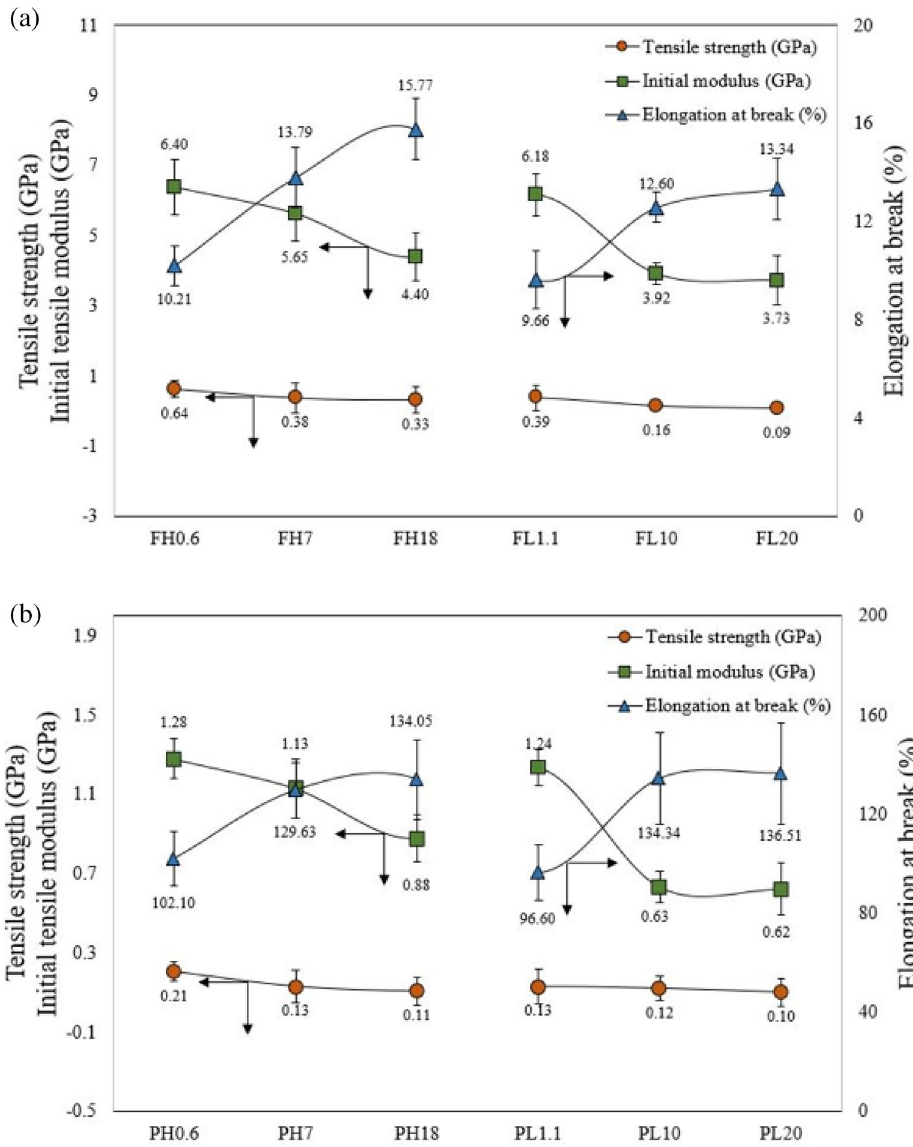
Figure 3. Tensile strength, initial tensile modulus, and elongation at break values of polyethylene precursor fiber with different draw ratio ( a ) Fully drawn polyethylene precursor fibers ( b ) Partially drawn polyethylene precursor